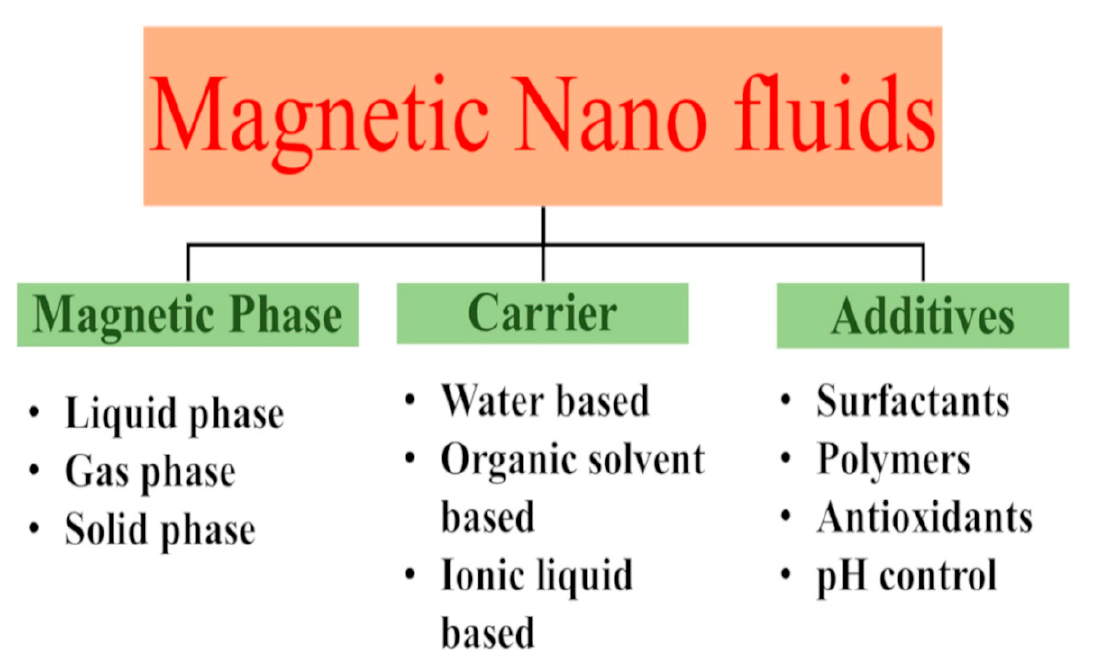
Figure 9. Schematic representation of the preparation of magnetic